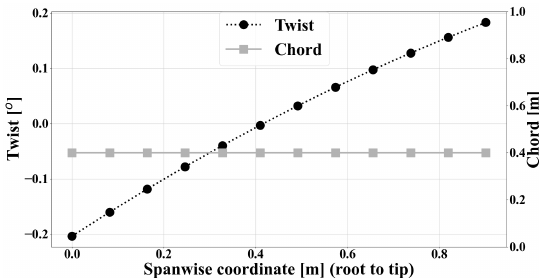
Figure 24. Wing twist and chord distributions.